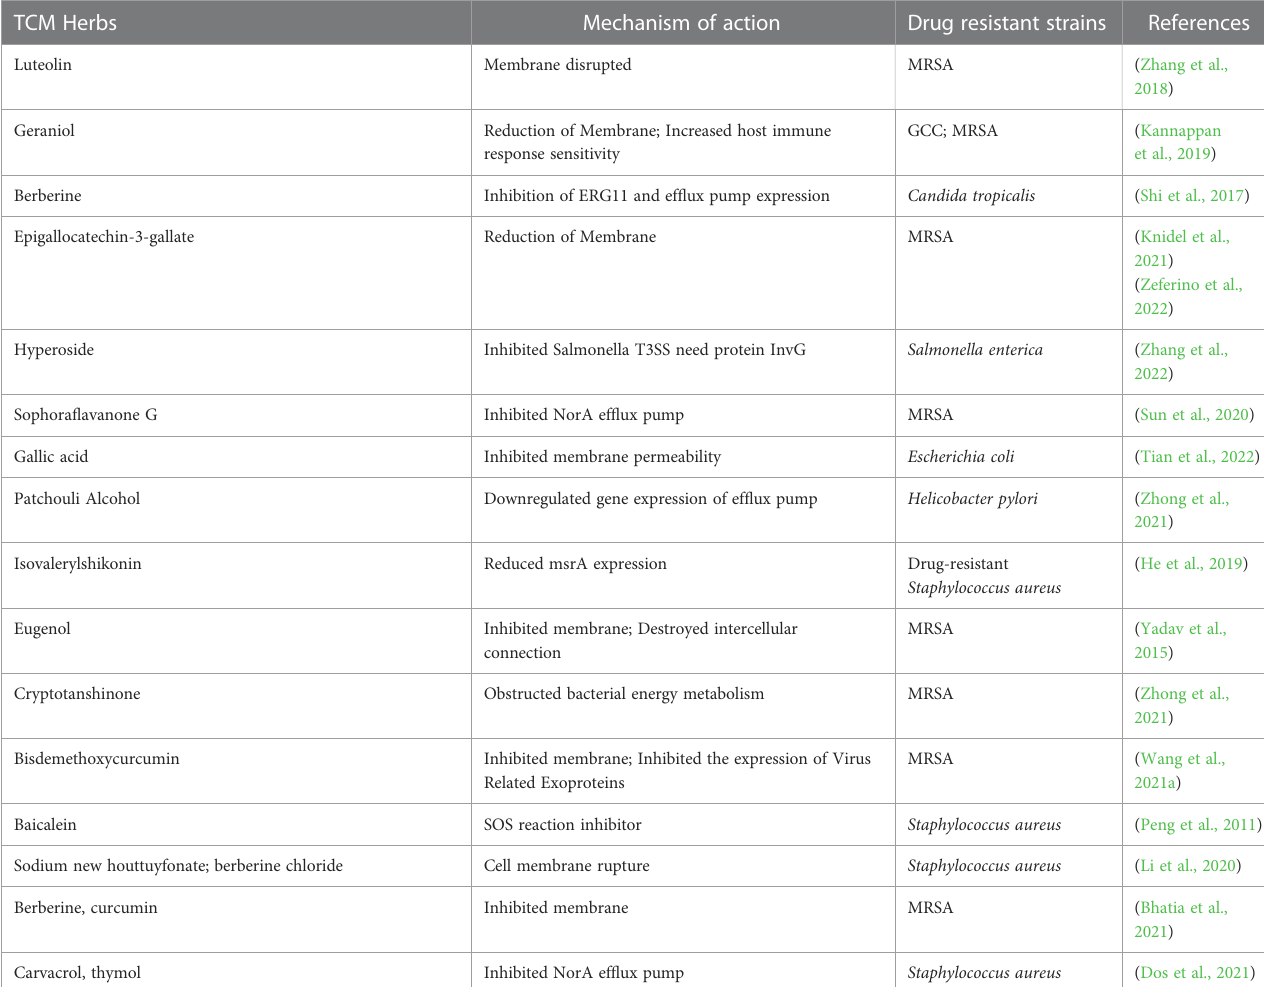
TABLE 3 Effect and mechanism of TCM and its effective components on antibiotic resistant bacteria. TCM Herbs Mechanism of